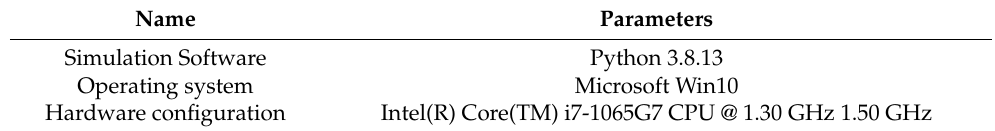
Table 5. Experimental conditions.